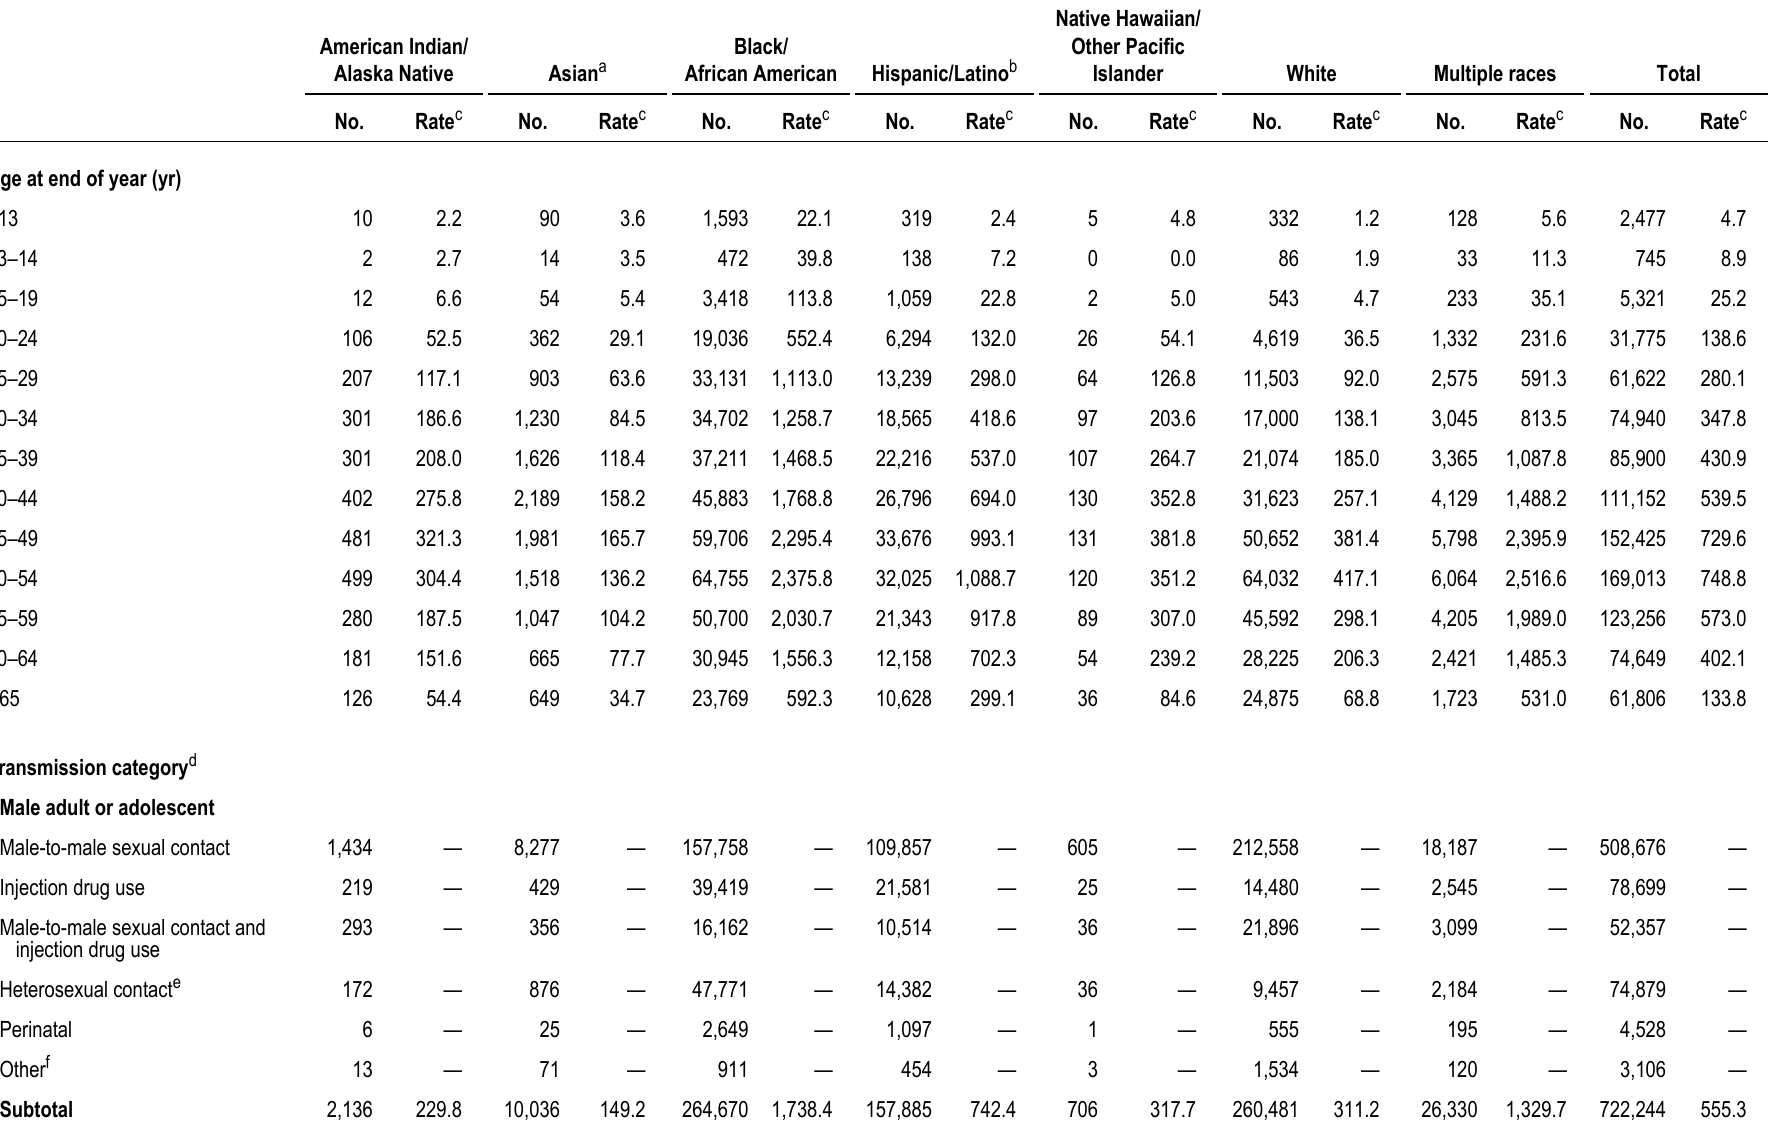
Table 20a. Persons living with diagnosed HIV infection, by race/ethnicity and selected characteristics, year-end 2014—United States Native Hawaiian/ American Indian/ Black/ Other Pacific Alaska Native Asian a African American Hispanic/Latino b Islander White Multiple races